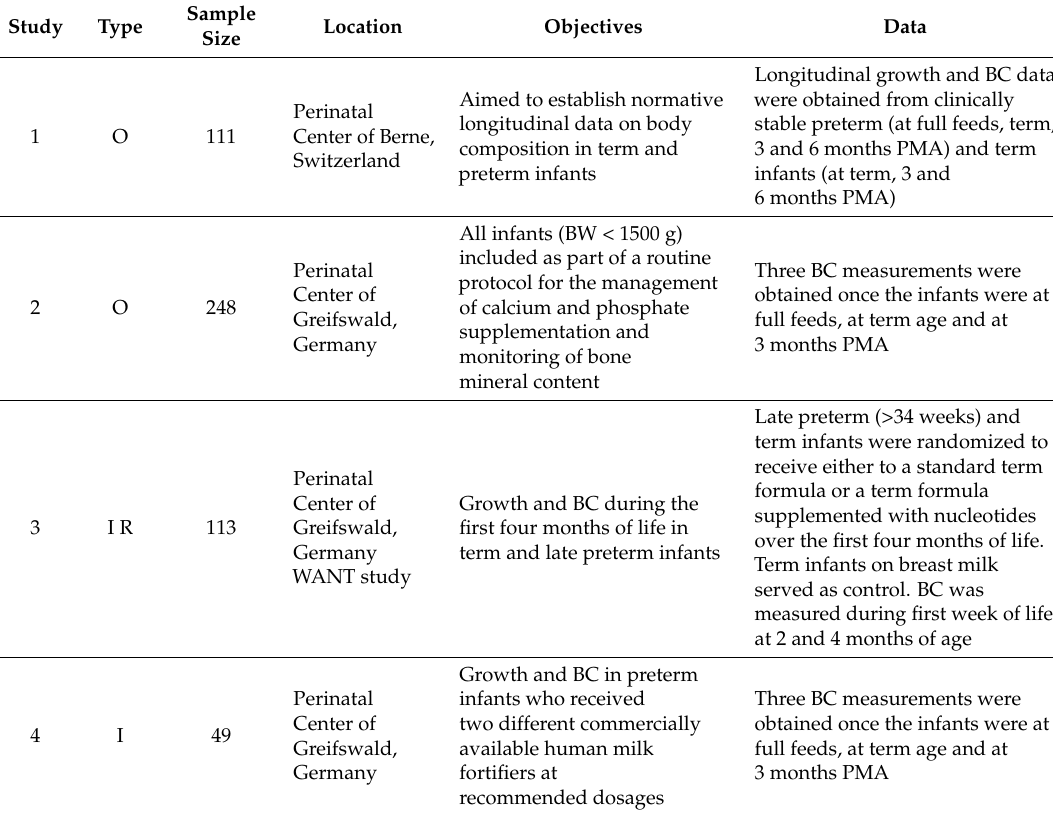
Table 1. Studies included for analysis of body composition